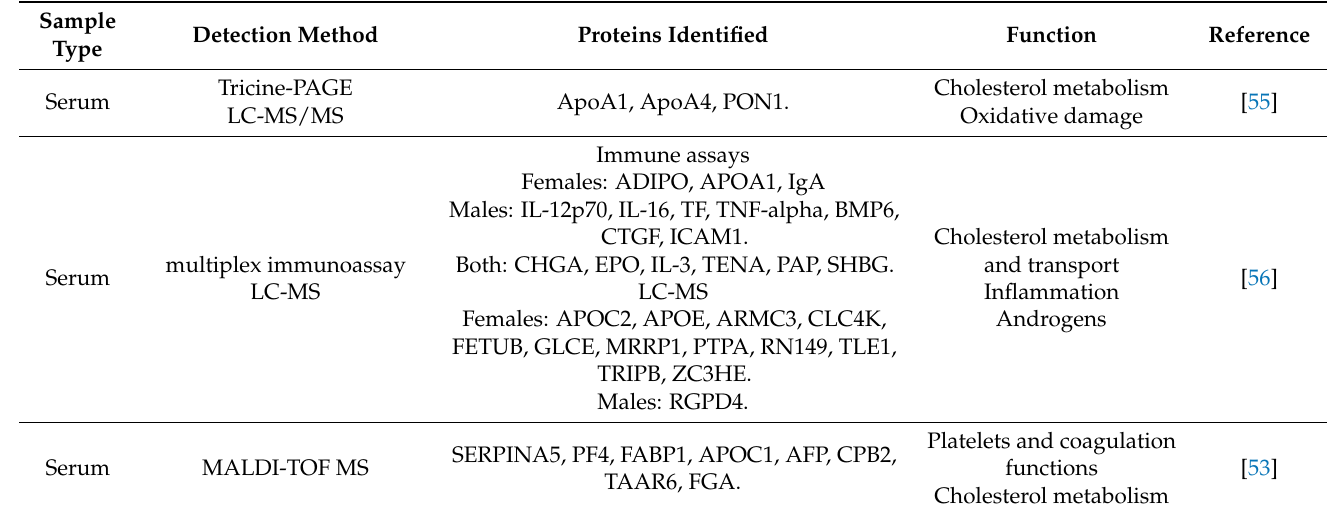
Table 2. Proteomics studies on